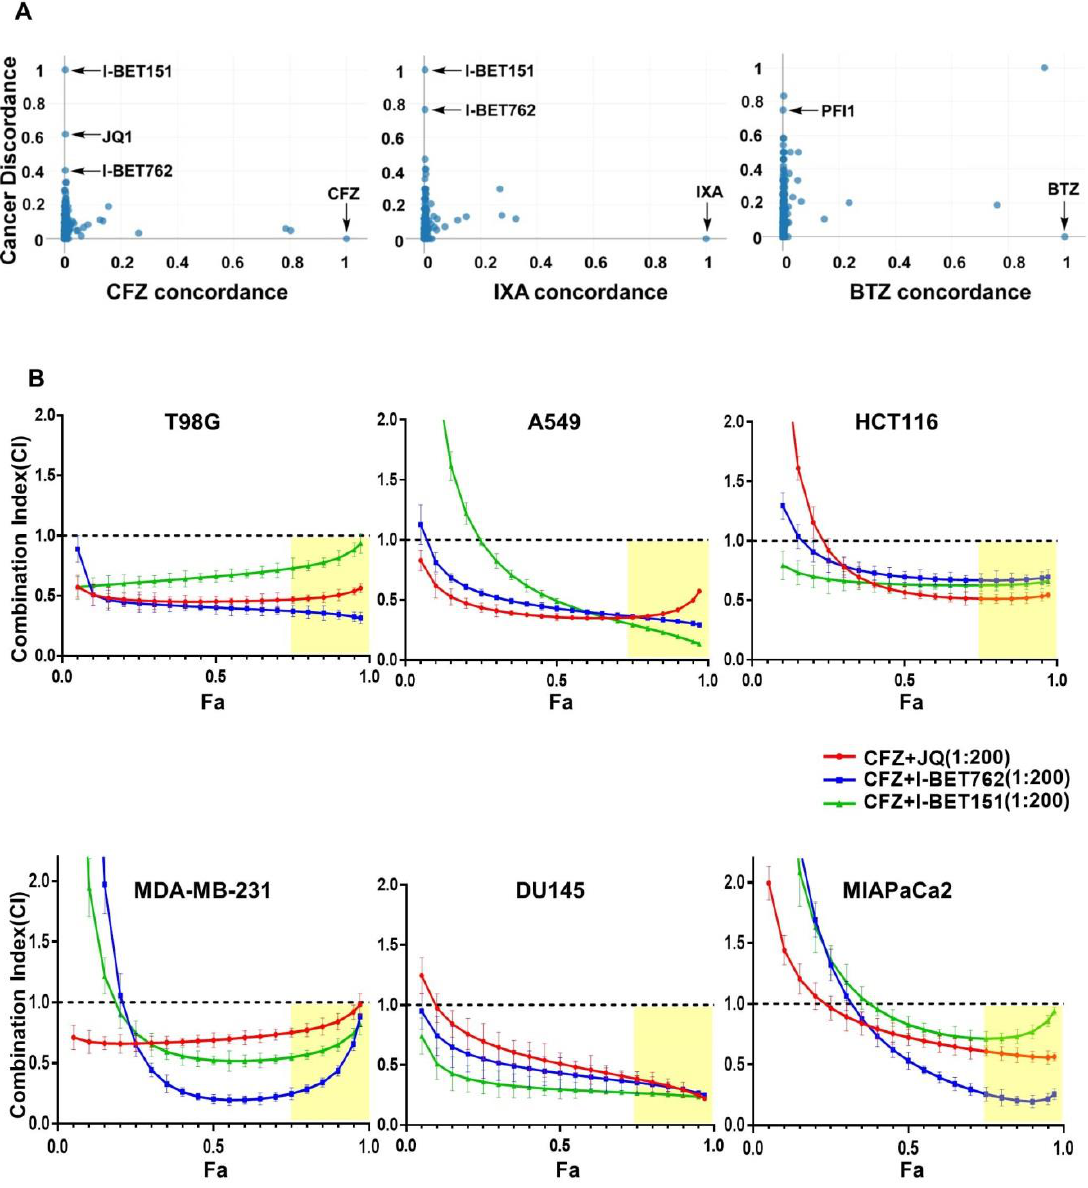
Figure 1. Synergistic interaction between proteasome and BET inhibitors in various cancer cells. ( A ) SynergySeq online platform was used to identify potential drugs that can synergize with proteasome inhibitors in cancer. “cancer discordance”, a measure of the ability of a drug to reverse cancer gene expression signature to a normal state, is shown on the y-axis. The level of similarity of a drug to the reference proteasome inhibitor drugs carfilzomib (CFZ), ixazomib-citrate (IXA), and bortezomib (BTZ) is shown as “concordance” values on the x-axis; ( B ) T98G, A549, HCT116, MDA-MB-231, DU145, and MIAPaCa2 cells were treated with di ff erent doses of CFZ (0.5, 2, 8, and 32 nM), along with one of the BET inhibitors (I-BET762, I-BET151, and JQ1) in di ff erent doses (0.1, 0.4, 1.6, and 6.4 µ M) as indicated for 72 h. In these combination treatments, the ratio of CFZ to BET inhibitors was maintained at 1:200. The combination index (CI) and fraction a ff ected (Fa) values were determined using CompuSyn software from cell viability data and are shown in these plots. The results are shown as mean ± SD, n = 3. CI < 1.0 indicates synergism, CI = 1.0 indicates additive e ff ect, and CI > 1.0 indicates antagonism. The regions highlighted in yellow are synergistic (CI < 1.0) at optimal Fa >